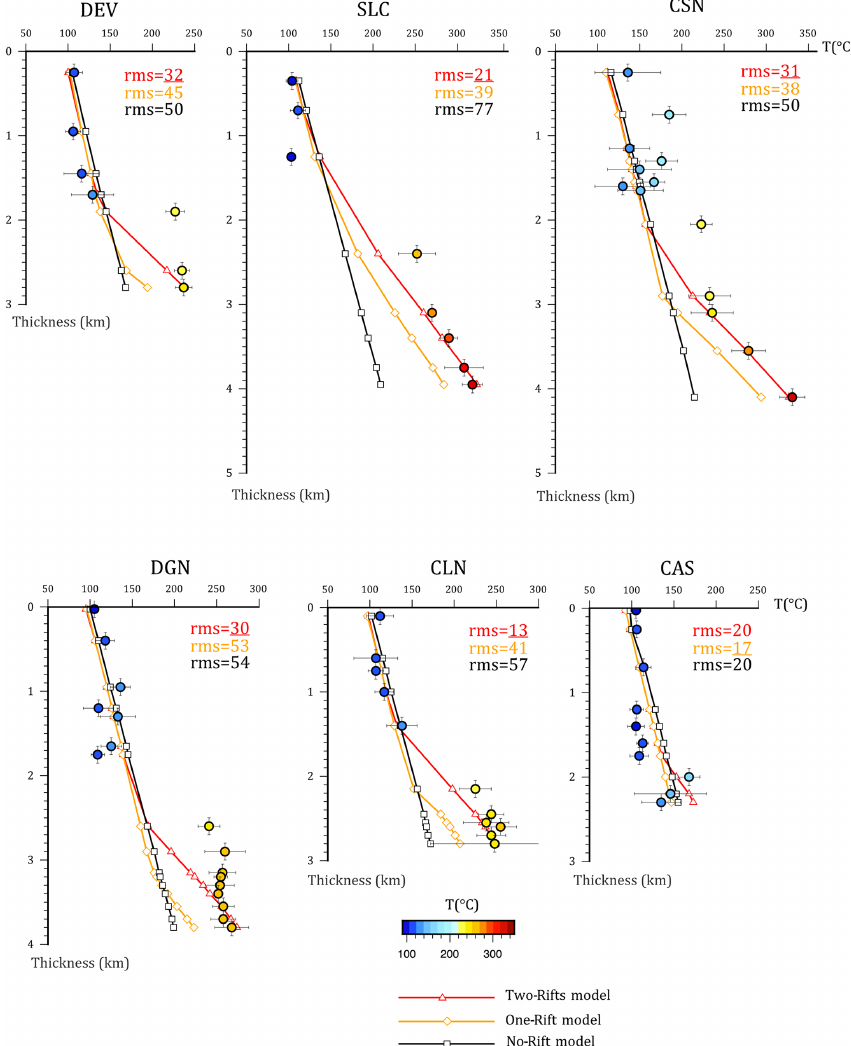
Figure 4. Comparison between observed RSCM temperatures (colour-coded circles) and temperatures computed based on tested tectonic models (Two-rifts, One-rift and No-rift) represented by colour-coded lines and symbols. The rms values represent the root mean square data misfit error calculated for each model. Reconstructed temperature–depth slopes correspond to thermal gradients: 30 ◦ Ckm − 1 (up section) and 80–90 ◦ Ckm − 1 (down section). The RSCM data are best reproduced for the Two-rifts model and if peak temperatures are achieved during the Early